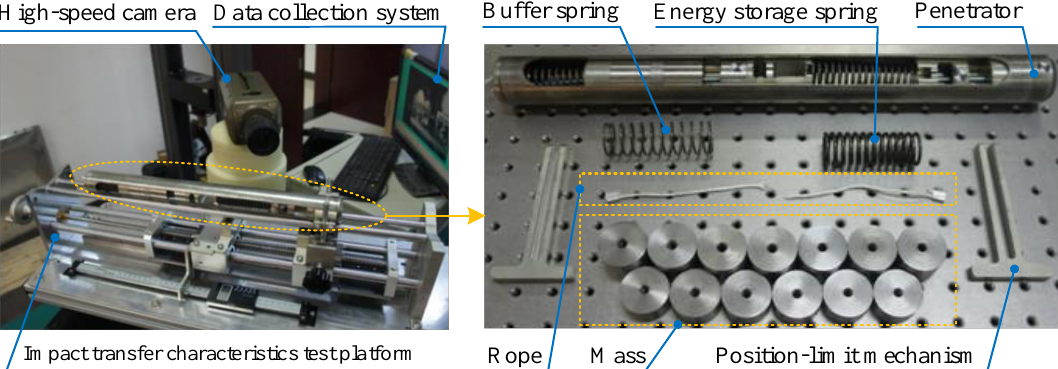
Figure 6. The major component of matching and stiffness matching parameters.